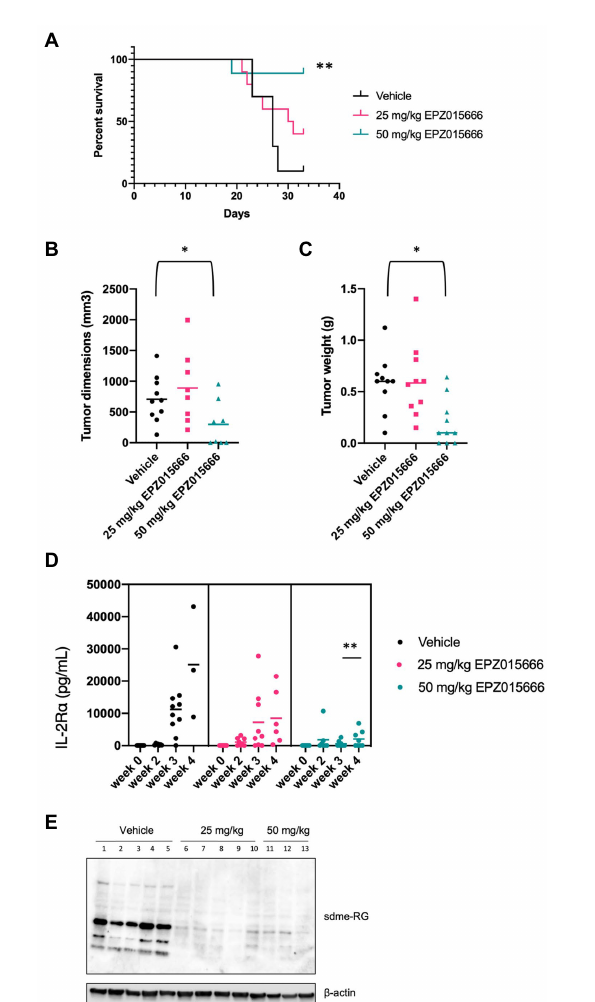
FIGURE 6 Inhibition of PRMT5 decreases tumor cell growth and increases survival in ATL-ED xenograft NSG mice. NSG mice were inoculated subcutaneously with 1×10 6 ATL-ED cells. All the mice